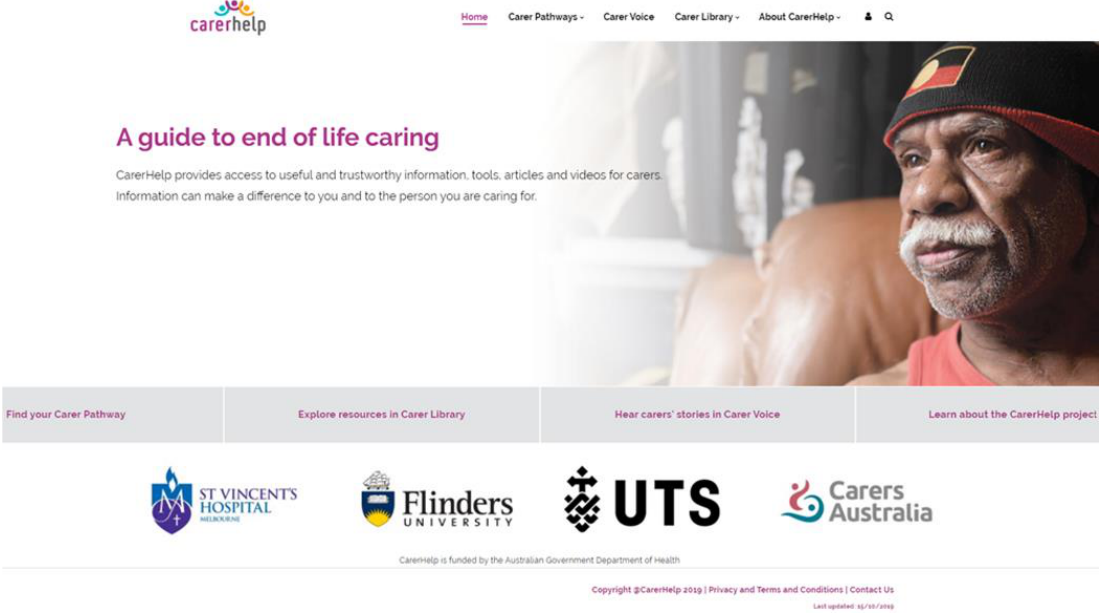
Figure 1. The Homepage of the Carers Toolkit prototype.